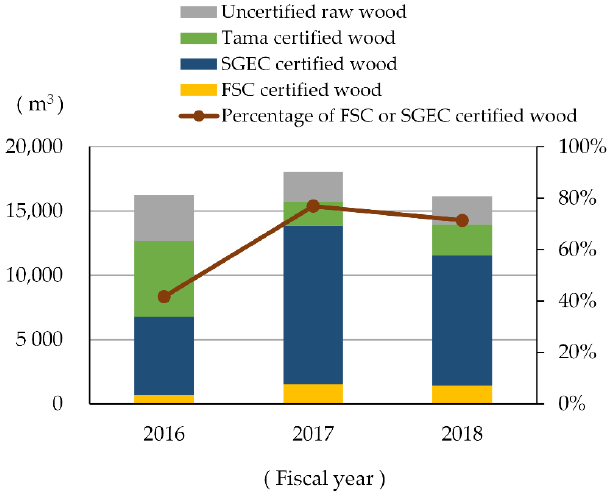
Figure 8. Handling volume of FSC- and SGEC-certified raw wood at Tama Roundwood Market Center.